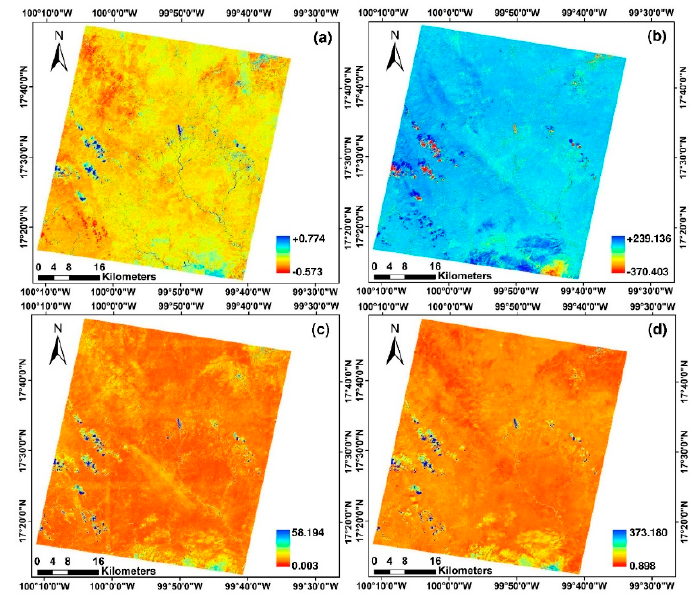
Figure 9. Change images resulting from the application of the detection models. ( a ) Linear Regression to NDVI images, ( b ) Linear Regression to first Principal Components PC1 images, ( c ) Chi-Square Transform to PC images, and ( d ) Change Vector Analysis (CVA) to PC images.